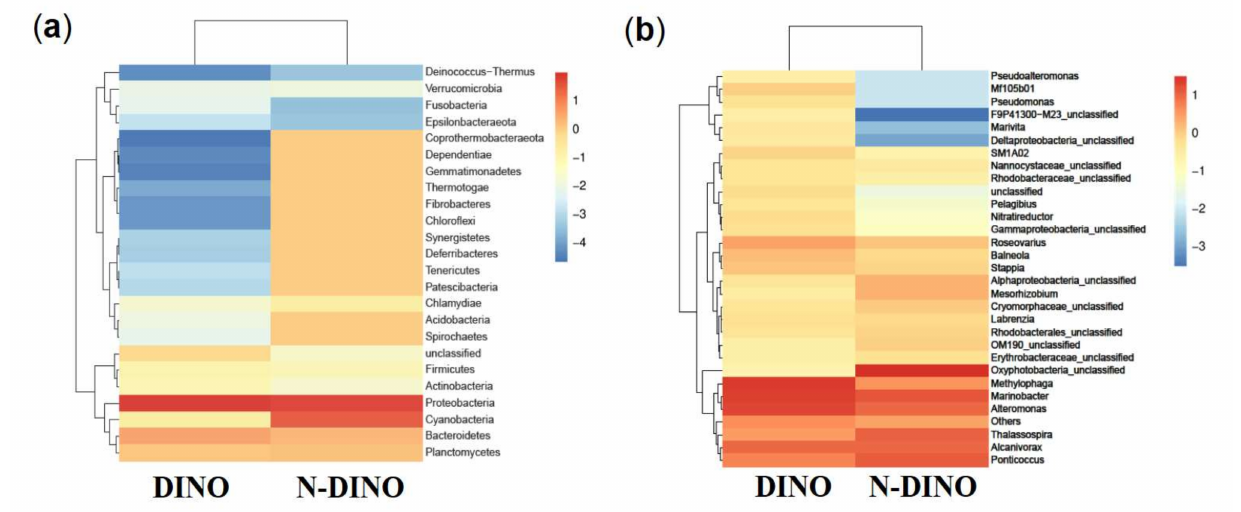
Figure 4. Heatmap of hierarchy cluster results representing the most abundant bacterial features at the phylum ( a ) and genus ( b ) levels in DINO and N-DINO